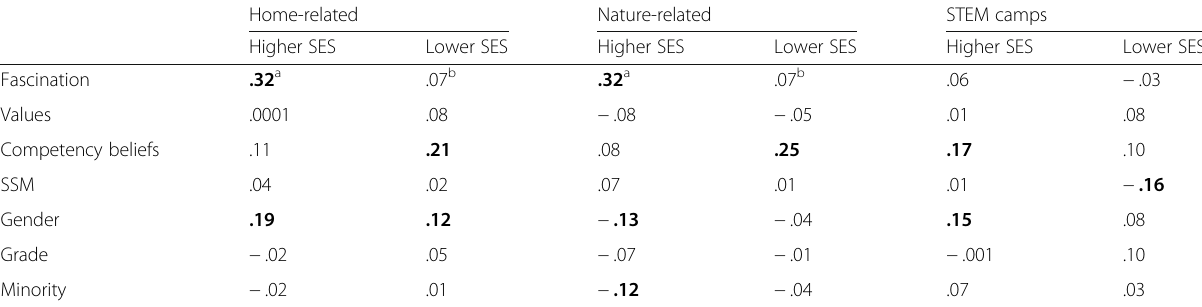
Table 6 Beta coefficients of the multiple linear regressions predicting participation in optional summer science experiences for higher SES and lower SES participants